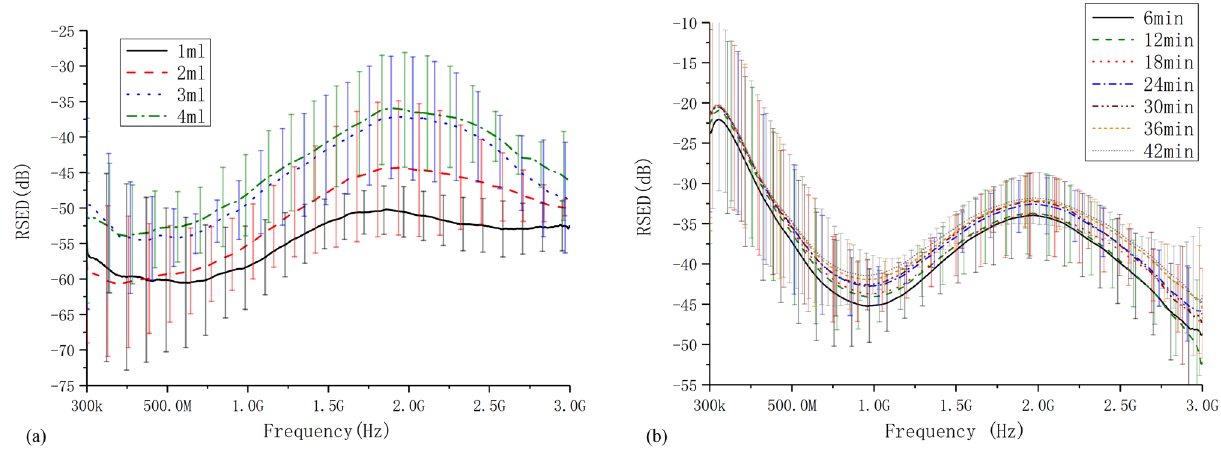
Figure 2. The average RSED of two groups (channel 1-1). ( a ) The RSED for the cerebral hemorrhage rabbit model. ( b ) The average RSED for the cerebral ischemia rabbit